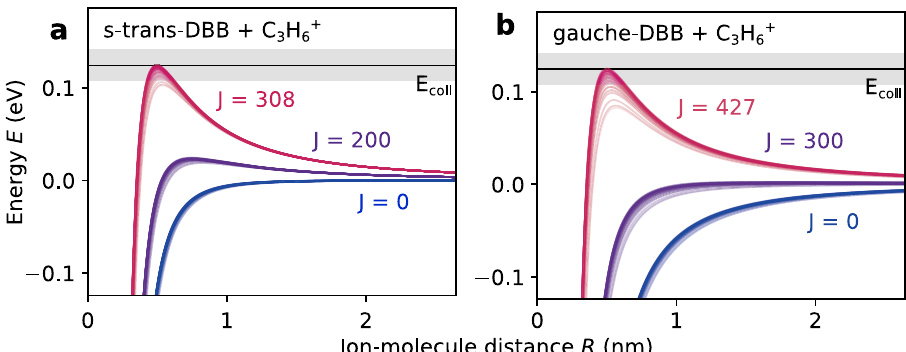
Fig. 5 Adiabatic capture calculations. Rotationally adiabatic, centrifugally corrected ion-molecule interaction potentials for the reaction of a s-trans - and b gauche -DBB with propene ions for different values of the total collisional angular momentum quantum number J . Each value of J comprises a set of lines corresponding to all rotational states of DBB with rotational angular momentum quantum number j = 4 that corresponds to the largest population in the molecular beam. The collision energy E coll is indicated by the black horizontal line and the grey-shaded areas represent its experimental